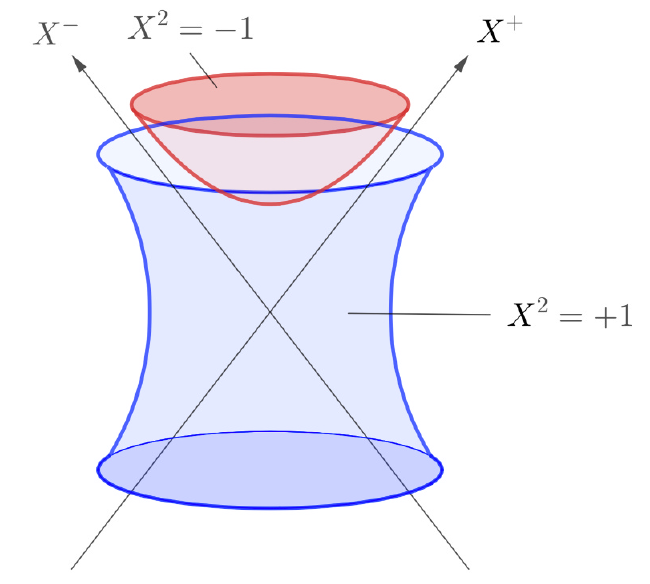
Figure 4 . The embeddings of the AdS space-time ( X 2 = (cid:0) 1) and the hyperboloid ( X 2 = 1) in R 2 ;d